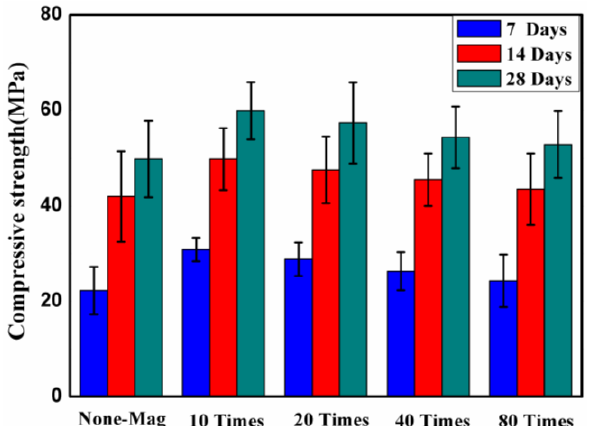
Figure 5. Compressive strength of concrete block pavers after 7, 14, and 28 days of curing in lime-saturated water.